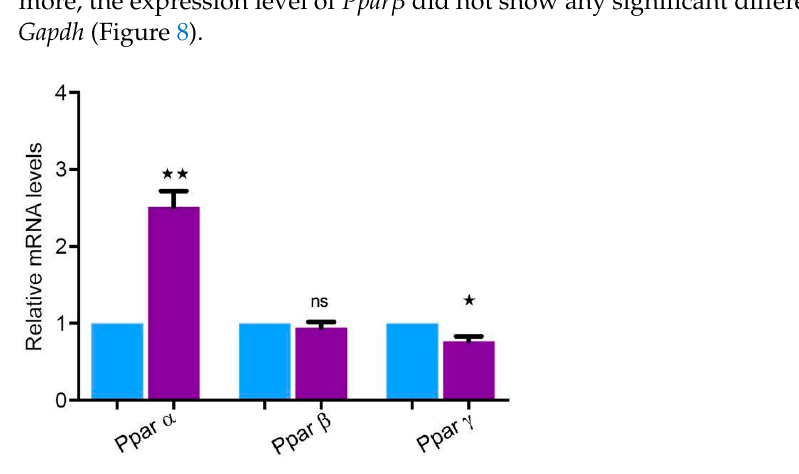
Figure 8. Peroxisomal proliferator-activated receptors in human parotid gland tissue. qRT-PCR analyses for mRNAs encoding for peroxisomal proliferator-activated receptors in human parotid tissues (violet bars) compared to Gapdh (blue bars) as a housekeeping gene. Ppar α was highly expressed in human parotid glands, whereas the expression of mRNA encoding for Ppar β showed no statistical significance. Ppar γ showed decreased expression. For the following mRNAs the respective p -value is Ppar α ** p < 0.0018, Ppar γ * p < 0.0213, ns: not significant.